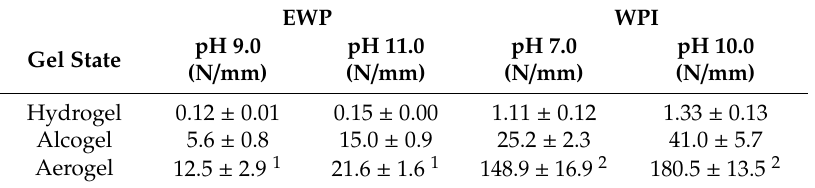
Table 2. Sti ff ness of gels in hydrogel, alcogel and aerogel state, calculated as required force per distance of